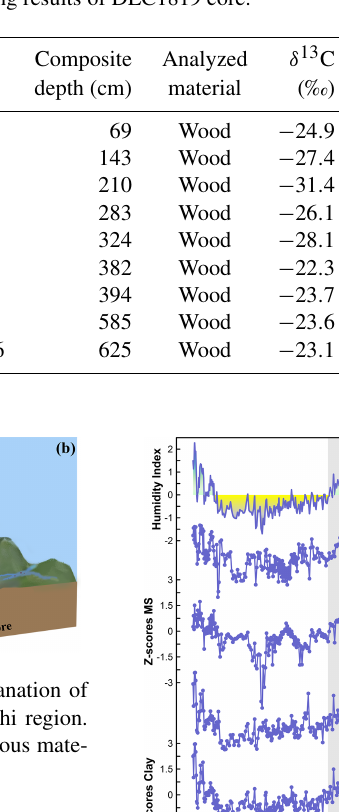
Table 1. Accelerator mass spectrometry (AMS) 14 C dating results of DLC1819 core.